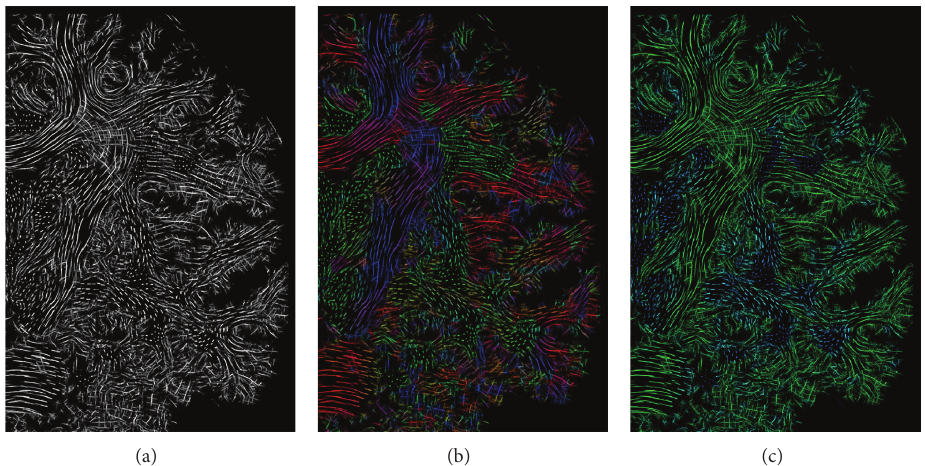
Figure 7: From left to right: section of a transaxial LIC slice image with gray scaling, and directional encoding with RGB and with HSB color